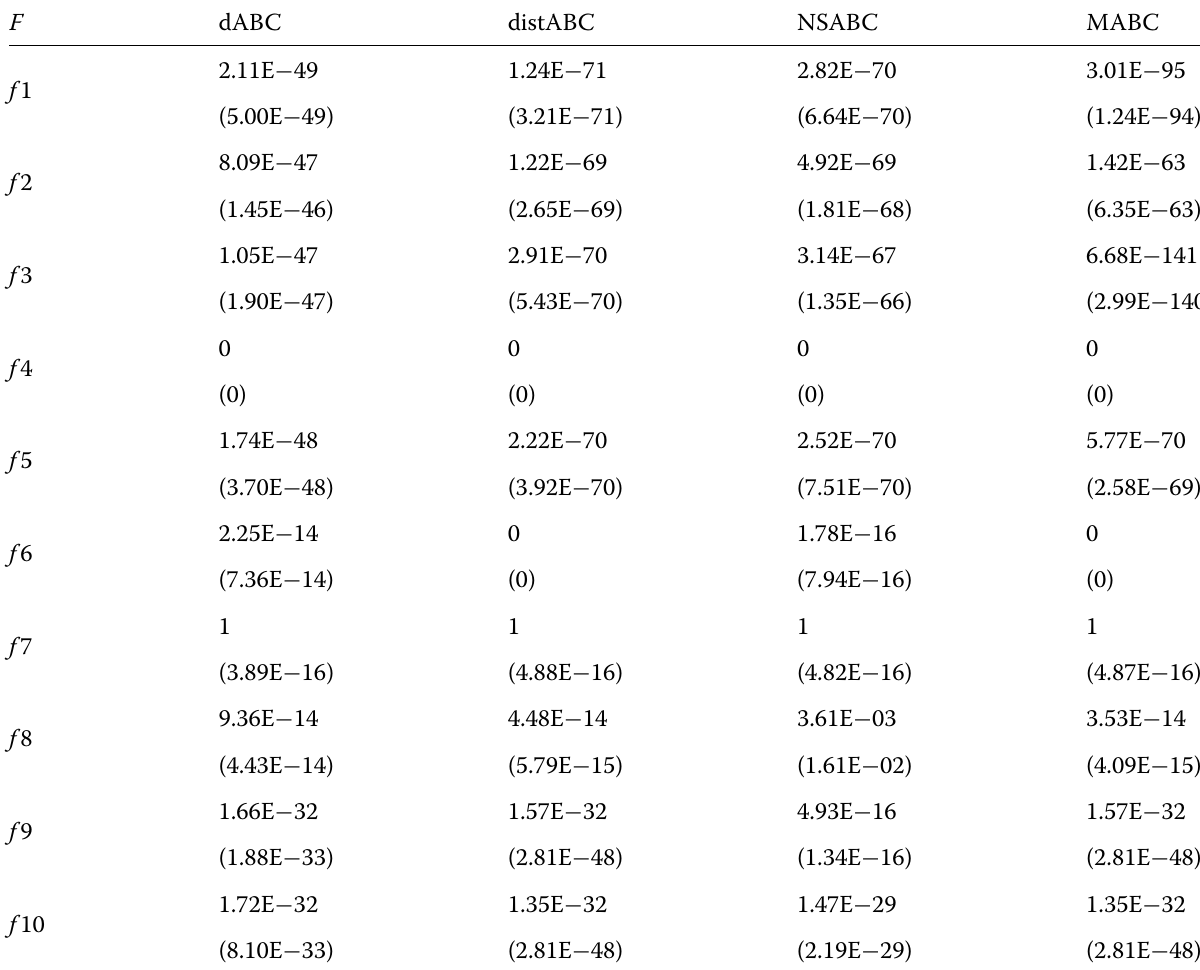
Table 6 Comparison results (2), D =